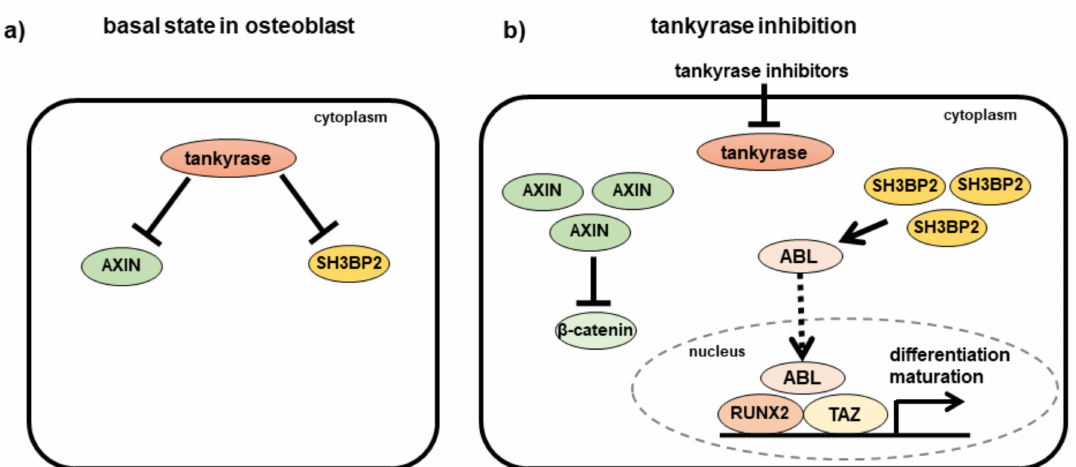
Figure 5. Effects of tankyrase inhibitors in osteoblasts. ( a ) Tankyrase inhibits expression levels of AXIN and SH3BP2 in physiological conditions. ( b ) In the presence of tankyrase inhibitors, both AXIN and SH3BP2 proteins accumulate excessively in the cells. Abundant AXIN suppresses β -catenin signaling. Simultaneously, accumulated SH3BP2 enhances activation of ABL and subsequent RUNX2-mediated gene expression, resulting in increased osteoblast differentiation and maturation. A solid arrow indicates direct stimulatory modification, a blunt-ended arrow indicates direct inhibitory modification, and a dashed arrow indicates translocation of the protein. RUNX2, runt-related transcription factor 2; TAZ,